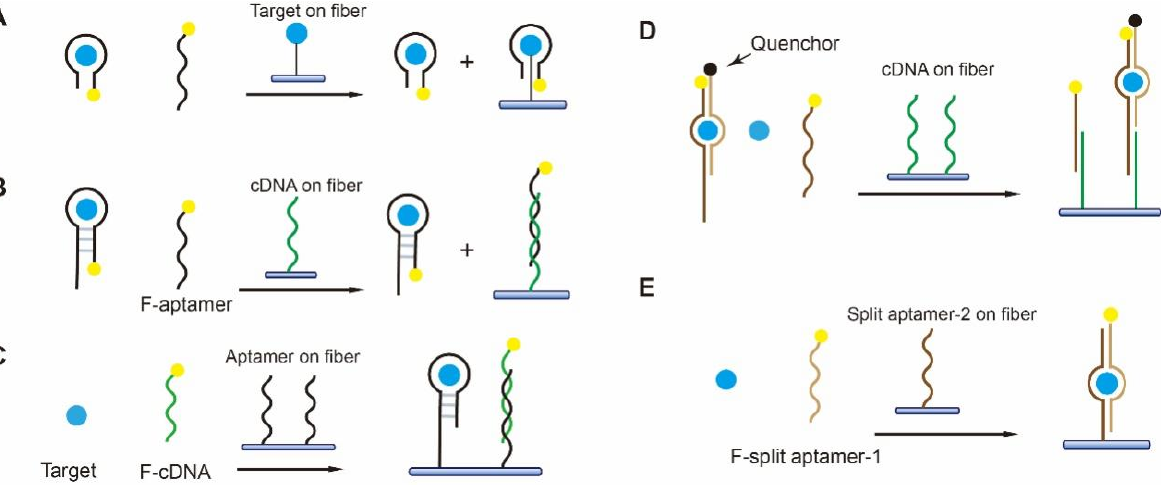
Figure 9. The separation-free detection of small-molecule targets using FNA-FOEW sensors installed with fibers functionalized by ( A ) target [85,86]; ( B ) cDNA [75]; ( C ) aptamer [71,72,77]; ( D ) cDNA complementary to one of the split aptamer fragments [73] ; or ( E ) one fragment of the split aptamer [76,80] .